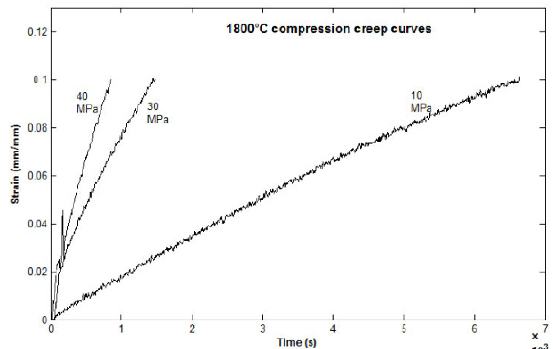
Fig. 4 Illustrative smoothed (moving average method) creep curves. Actual data were used in calculating the strain rates. Not all data were included for the clarity of the figure.